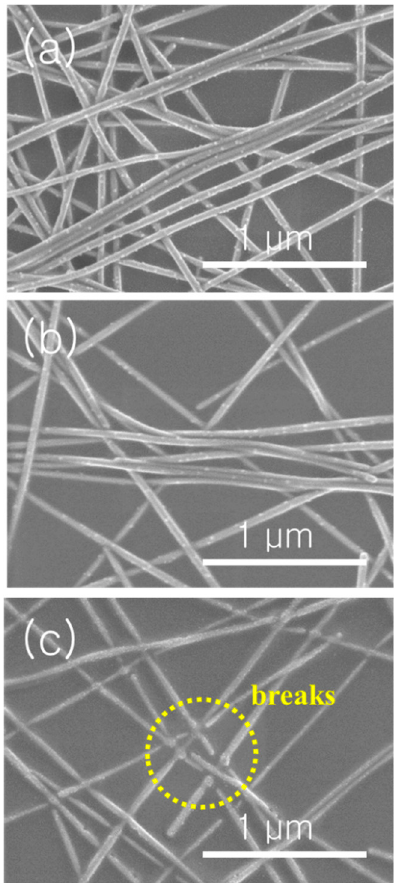
Figure 4. SEM images of Ag NW networks after irradiation under an irradiation energy density of 1.02 J/cm 2 and a duration time of ( a ) 1 ms, ( b ) 2 ms, and ( c ) 5 ms. 1.02 J / cm 2 and a duration time of ( a ) 1 ms, ( b ) 2 ms, and ( c ) 5